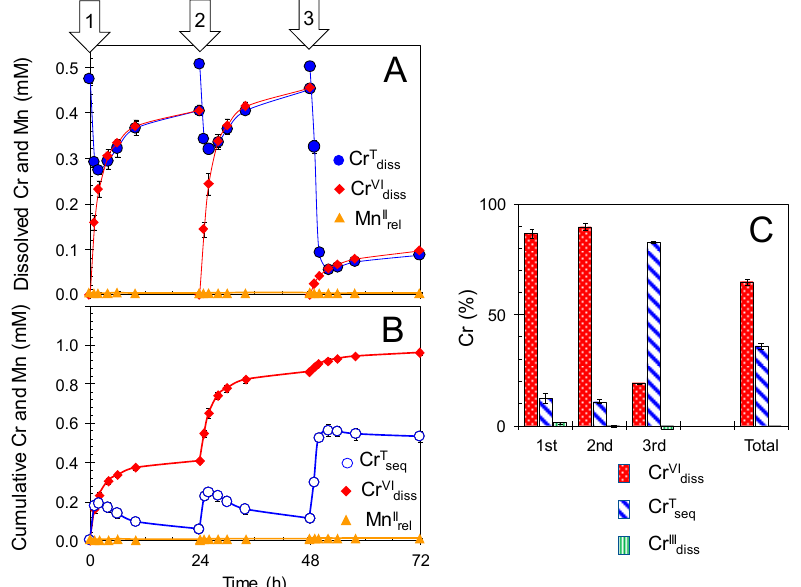
Figure 3. Repeated treatments of newly formed biogenic manganese oxides (BMOs; 1 mM as Mn) with 0.5 mM Cr(NO 3 ) 3 under aerobic conditions at pH 6.0 (100 mM MES buffer). ( A ) Concentrations of total Cr dissolved (Cr Tdiss ), Cr(VI) dissolved (Cr VIdiss ), and Mn(II) released (Mn IIrel ). ( B ) Cumulative concentrations of total Cr sequestered (Cr Tseq ), Cr VIdiss , and Mn IIrel . ( C ) Percentages of Cr VIdiss , Cr Tseq , and Cr(III) dissolved (Cr IIIdiss ) during the repeated treatments. Bathing solutions were renewed every 24 h for 3 days (indicated by arrows). Data are shown as mean ± standard deviation (n = 3).